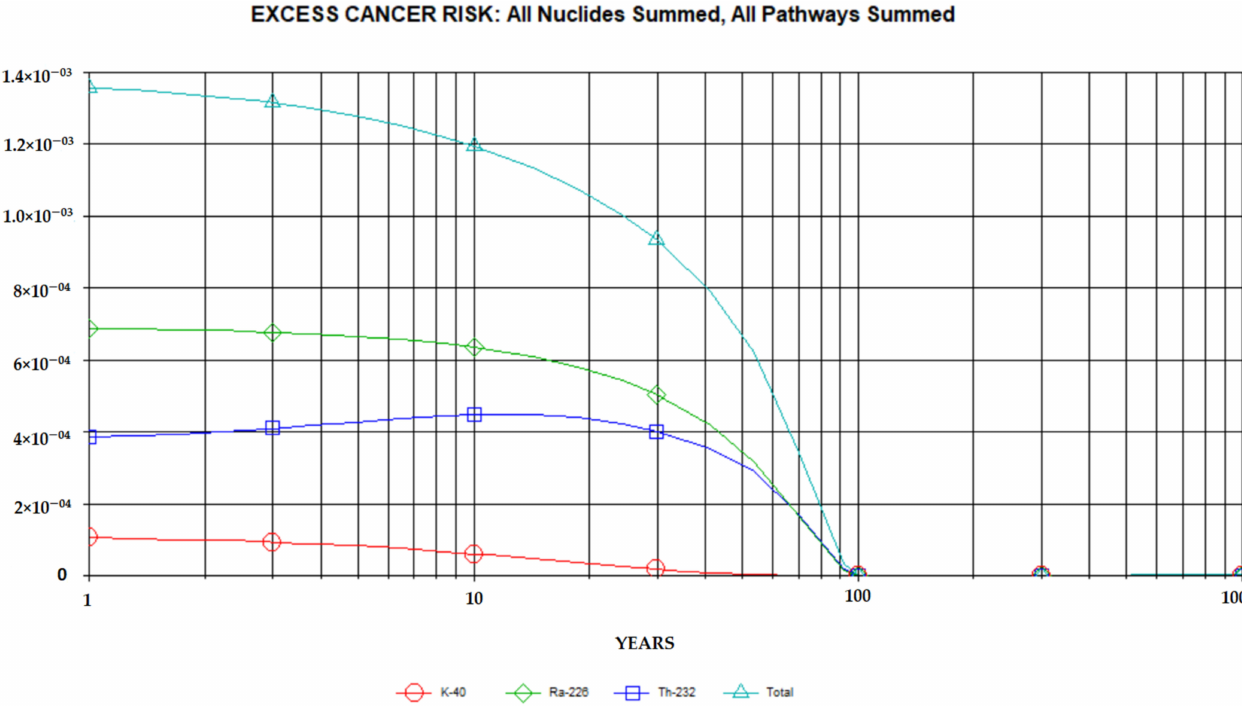
Figure 5. Cancer risk depending on time and contributions from all